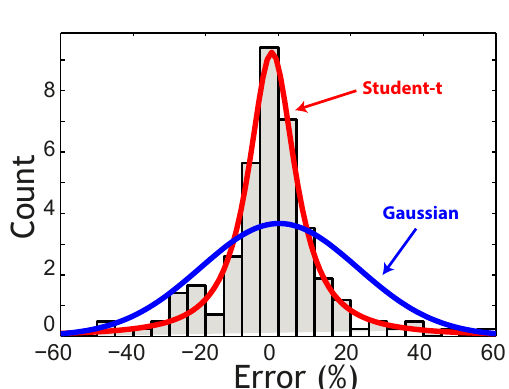
Fig. 9. Distribution of area errors between H93 and GI old for all glaciers mapped in the same year, as a percent of the glacier area showing Gaussian and student-t distributions fit to the data. The heavier tails of the student-t distribution reflect the effect of larger blunders on glacier outlines, presumably due to varying hydrological divides and debris cover/lateral moraine delineation between the area estimates.